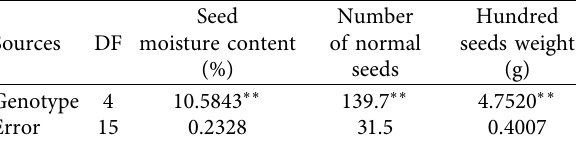
Table 1: Te mean squares from the analysis of variance for the physical seed quality test of prepriming seed of fve okra